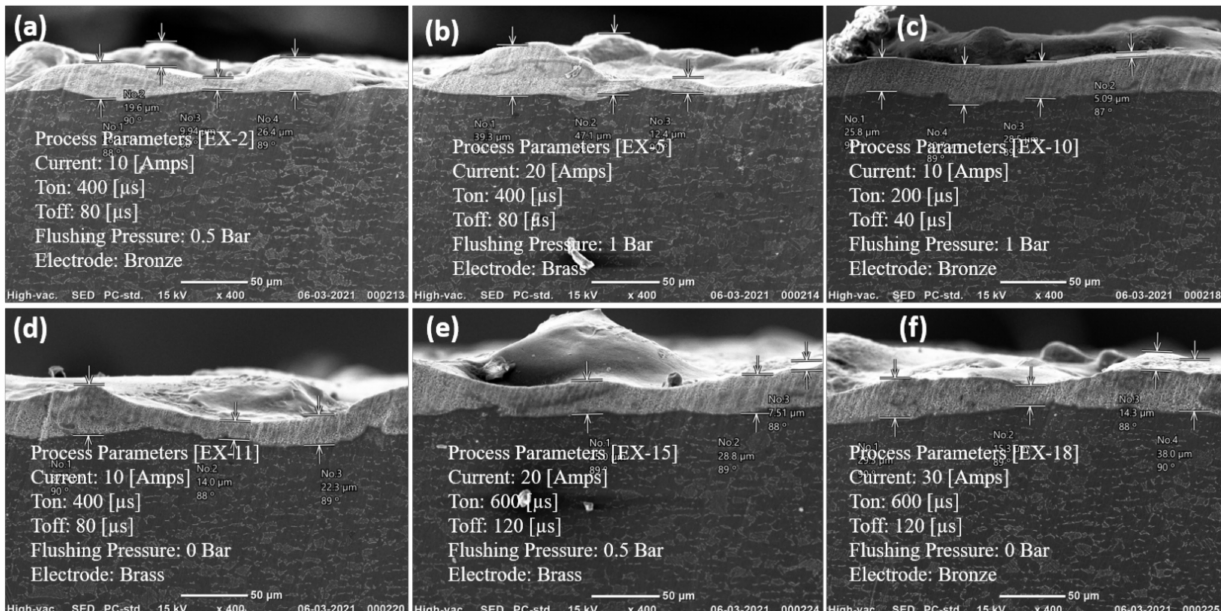
Figure 5. EDC Coating Thickness: ( a ) EX 2, ( b ) EX 5, ( c ) EXP 10, ( d ) EX 11, ( e ) EX 15 and ( f ) EX 18 (all SEM images are 400 × ).